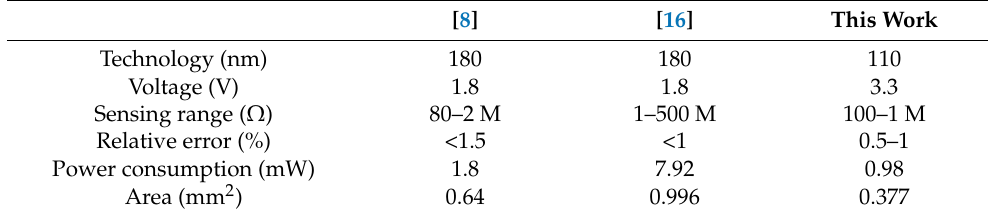
Table 2. Performance comparison of interface